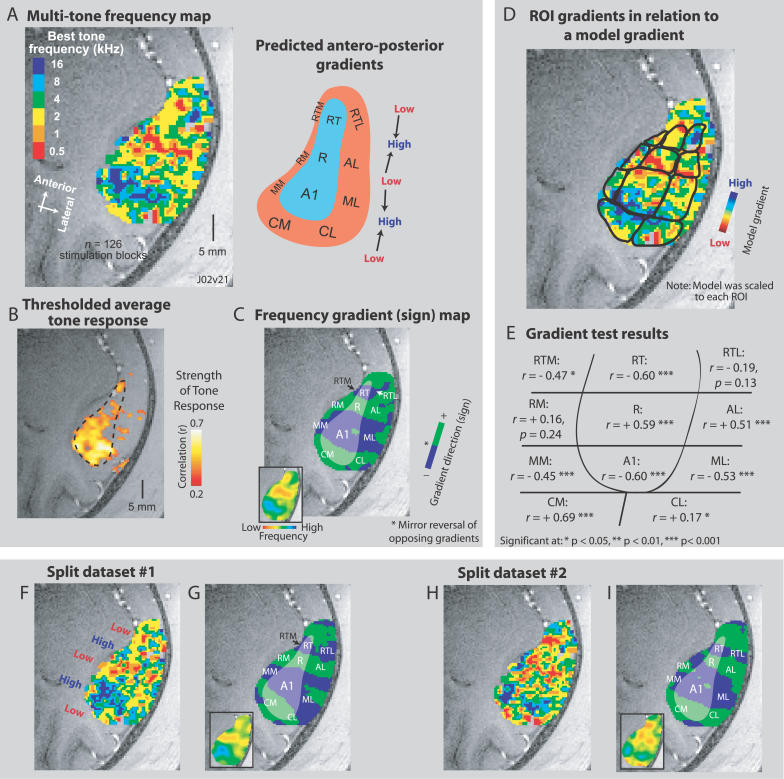
Delineating Borders and ROIs over Auditory Cortex(A) Multiple tone-frequency map, resulting from the presentation of six tone frequencies individually in pseudo-randomized stimulation blocks. The best-tone frequency response of the significantly active voxels is color-coded (see “MRI data analysis” in
Materials and Methods). Tone activations were extensive over auditory cortex, see text. Right of (A) schematizes the ACFs that could be active in this broad region including the directions (from Low to High) of the expected frequency selective gradients.
(B) The core preferentially responds to tones in comparison to belt regions [
19,
21]. An “auditory core” ROI was drawn around the average tone response, thresholded to the approximate length (˜1.8 cm) and full width (˜0.8 cm) of the core [
3].
(C) The results of a gradient analysis that assigns a sign to gradients progressing in the anterior direction, along an axis predetermined by points underneath labels H1 and L2 from the data in
Figure 3A. Along this axis, gradients that progress anteriorly from low to high frequencies, ascending gradients, are assigned a positive sign (green) and those from high to low, descending gradients, a negative sign (blue). Multiple mirror reversals of frequency gradients are observed and borders between ACFs are delineated where signs reverse, or the two colors meet. The smoothed version of the multi-frequency map (A) used for the gradient analysis is inset in (C). The area of the “auditory core” ROI from (B) is overlaid in transparent white over the map in (C).
(D) Auditory cortex ROIs were delineated relying on the gradient sign map borders, shown here overlaid on the data from the multi-tone frequency map. Each ROI's gradient from the multi-tone data was tested in relation to a model gradient progressing from low to high values anteriorly, see colorbar.(E) Reports the results of the ROI gradient tests as correlation coefficients,
r, and associated
p-values. The combined analyses localize many auditory fields with mirror reversed frequency gradients and functionally tessellate large portions of auditory cortex. (F–I) Split datasets from the entire experiment. Format as for panels (A and C).